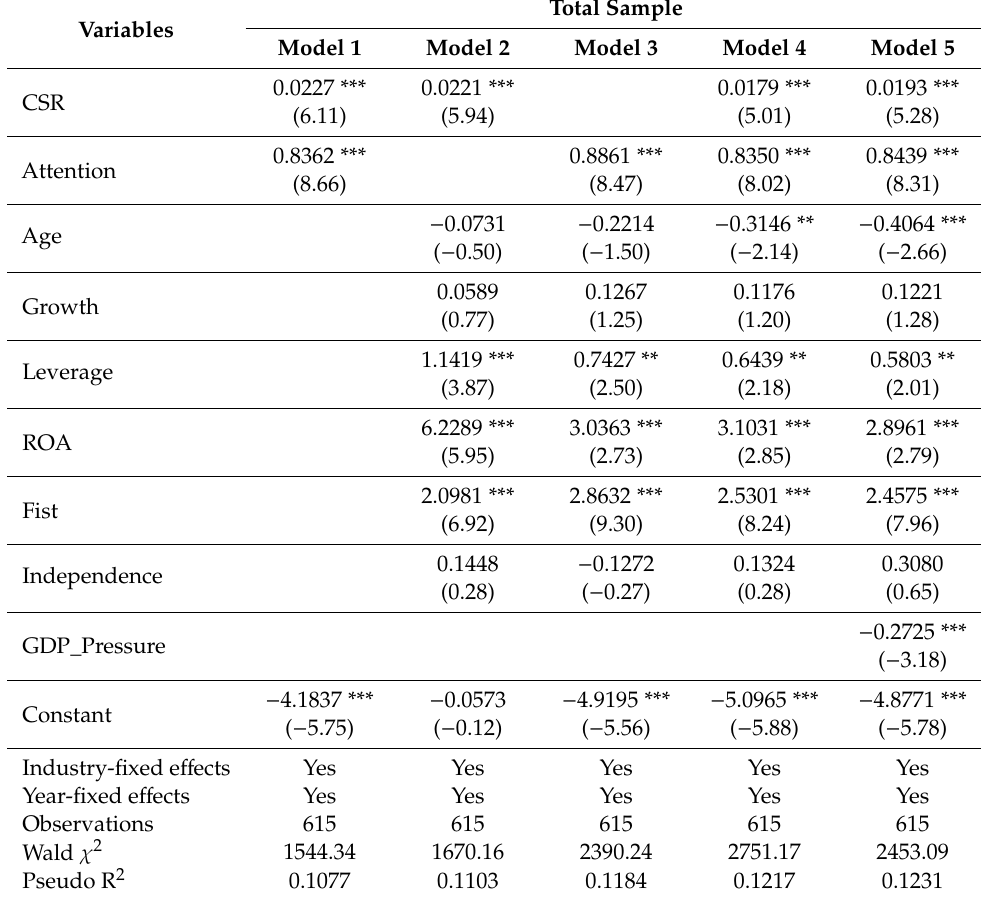
Table 4. The Regression Results of the Total